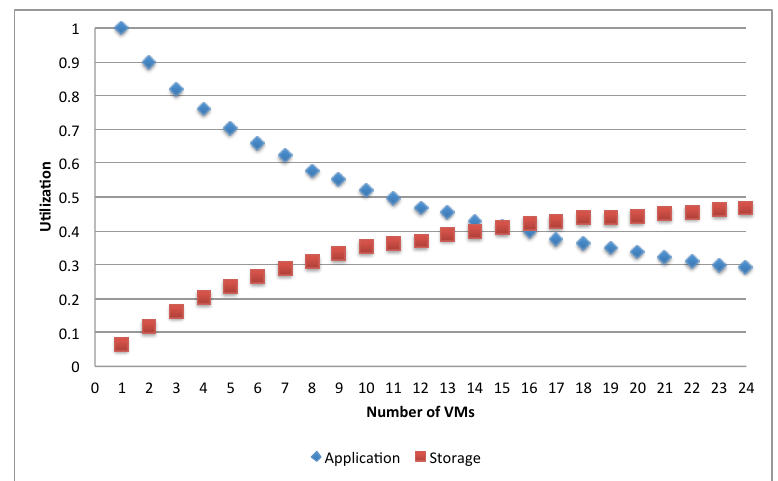
Figure 15. Bottleneck switching with synchronous access.